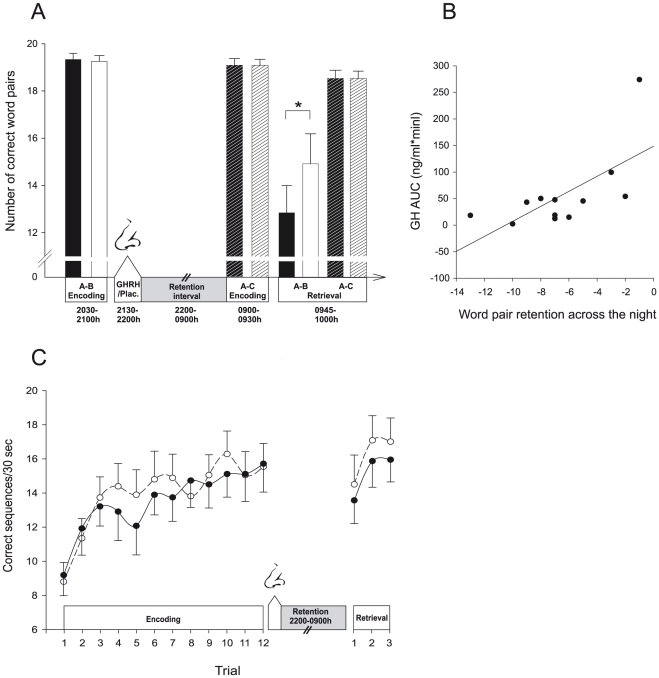
GHRH impairs declarative memory consolidation.(A) Declarative memory: Mean (± SEM) performance on the word pair interference task as assessed by the number of correctly recalled word pairs in the GHRH condition (black bars; intranasal administration of 600 µg GHRH1–44 from 2130–2200 h) and the placebo condition (white bars; vehicle). Encoding of the A–B word pair list (plain bars) took place before substance administration and a nocturnal retention interval of 11 hours spent awake. Encoding of the A–C word pair list (hatched bars) took place after the retention interval. Retrieval of both lists was jointly tested at the end of the session. GHRH administration significantly reduced retention of A–B word pairs whereas retrieval of the A–C interference list remained unaffected. * P<0.05. (B) Retention of word pairs in the GHRH condition plotted against respective 2200-0045 h plasma GH AUC values, indicating a positive correlation between consolidation of word pairs and post-learning somatotropic activity (r = 0.66, P = 0.019; note that excluding the subject with the highest plasma GH AUC value from analysis yielded essentially the same result, r = 0.61, P = 0.046). (C) Procedural memory: Mean (± SEM) finger tapping performance indicated by the number of correct sequences within a 30 sec trial during encoding and after the retention interval following intranasal administration of GHRH (black dots, solid lines) and vehicle (white dots, dashed lines), respectively. Encoding consisted of twelve 30-sec trials and retrieval testing comprised three 30-sec trials. Unlike declarative word pair memories, procedural finger tapping skill was not affected by GHRH. N = 12.